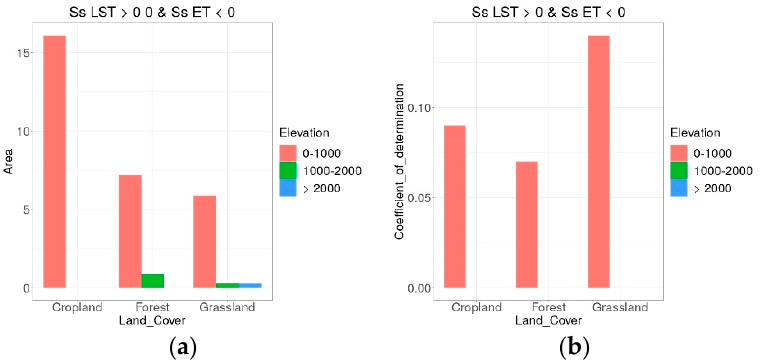
Figure 19. Percentage of area in each land cover class where LST and SSEBop ET trends overlap, per elevation ( a ) and corresponding r 2 ( b ). The combination of positive or negative ET and LST trends is indicated in the title of each plot. “Area” on the y axis is the percentage of the total area within each land cover class. Ss is the Sen’s slope of the trend at 5% significance from 2003 to 2019.